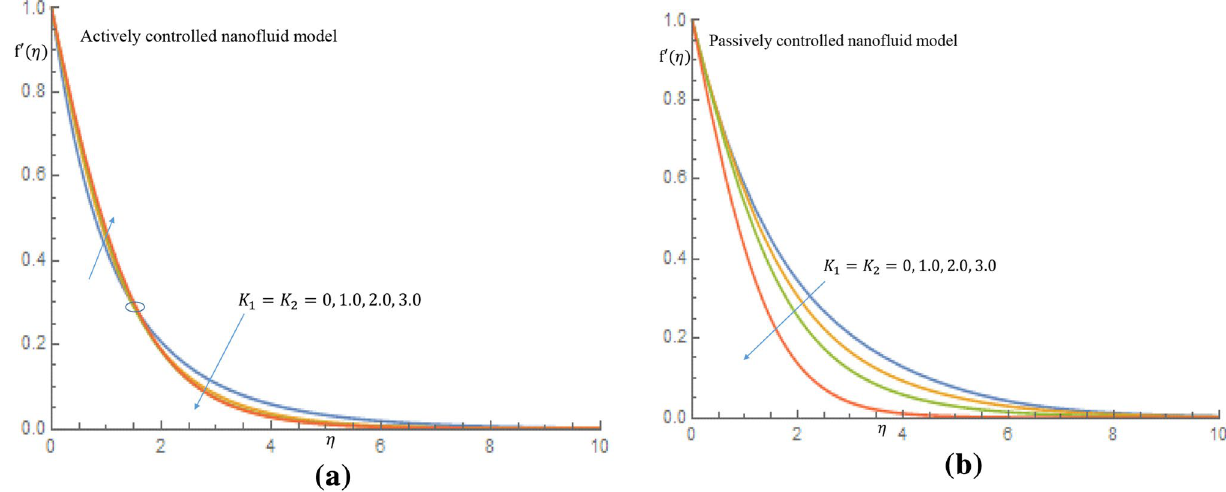
Nu x θ ′ ( 0 ) for various values of P r , N b and N t when M = G r = N r = R b = 0.5, √ Re x = −